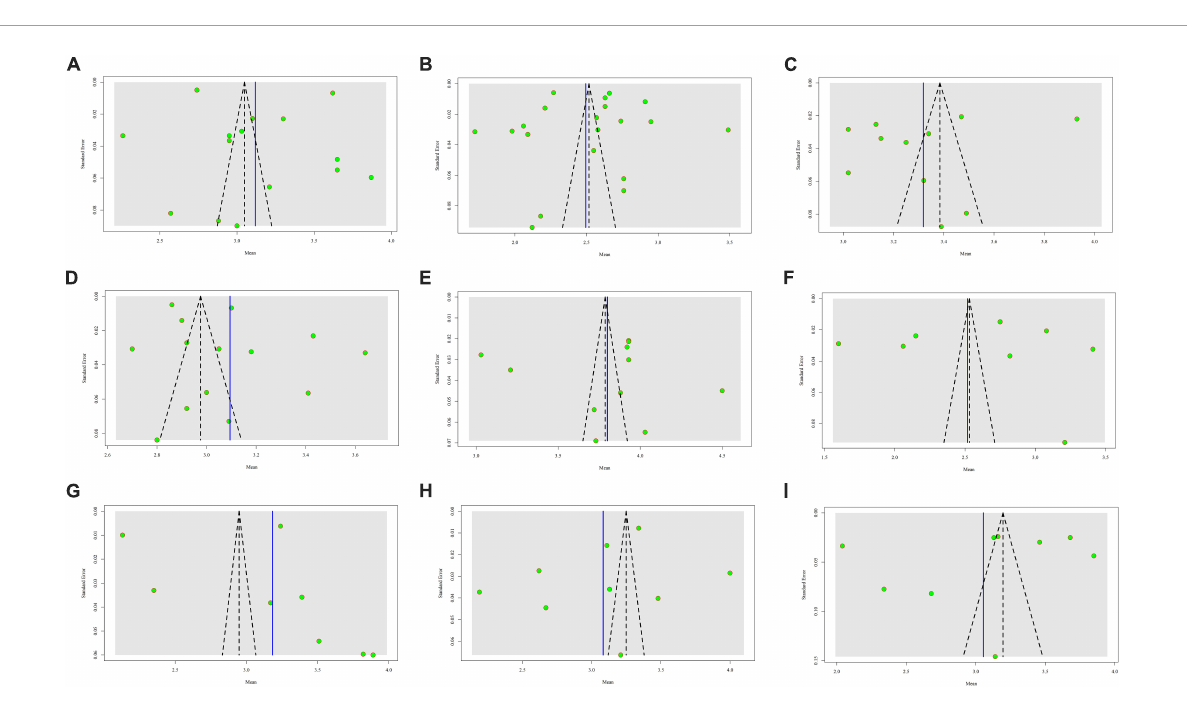
hospitals in cities or counties (72–74). A survey on the